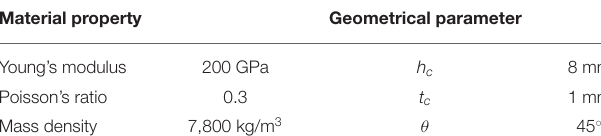
TABLE 1 | Material properties and geometrical information.